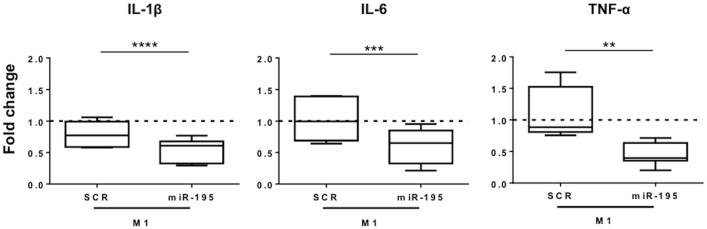
Levels of IL-1β, IL-6 and TNF-α secreted by macrophages after miR-195 overexpression upon pro-inflammatory stimulation.miR-195 mimic was transfected into THP-1 macrophages before stimulation with LPS and IFN-γ. After 24h, cell culture medium was collected and levels of IL-1β, IL-6, and TNF-α were determined by ELISA. Graph show results relative to non-transfected, M1-stimulated THP-1 macrophages. Three independent experiments were performed in triplicate. Statistical significance: **p<0.01, ***p<0.001, ****p<0.0001.